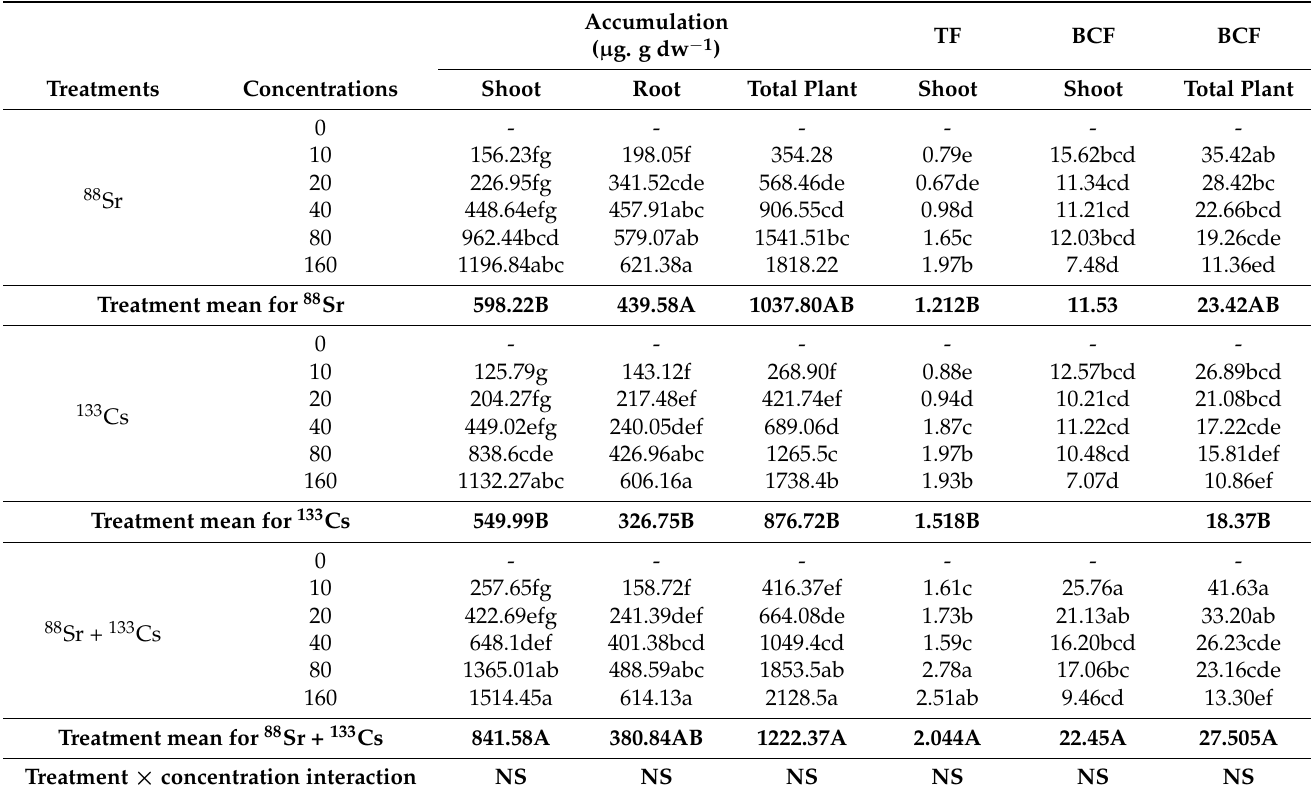
Table 3. The effect of 88 Sr, 133 Cs, and 88 Sr + 133 Cs on the bio-accumulation of plants and phytoextrac- tion potential.